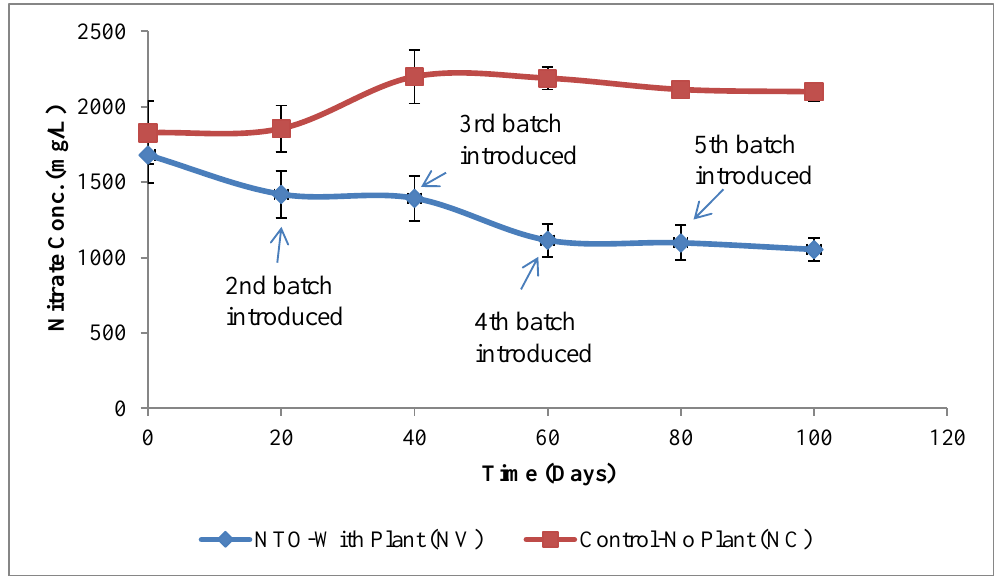
Figure 2. Change in nitrate concentration in NTO-wastewater during the 100 d experiment. New batches of vetiver plants were introduced in NTO with plant (NV) treatments every 20 days. In control experiments (NC), containers of NTO were maintained without vetiver plants. For NV treatments, 37.26 ± 4.52% (±SD) reduction in nitrate in the NTO-wastewater in comparison to its initial value was observed during this study. In contrast, for the NC treatments, nitrate concentration increased by 14.88 ± 3.34% (±SD) on average from its initial concentration during the study.